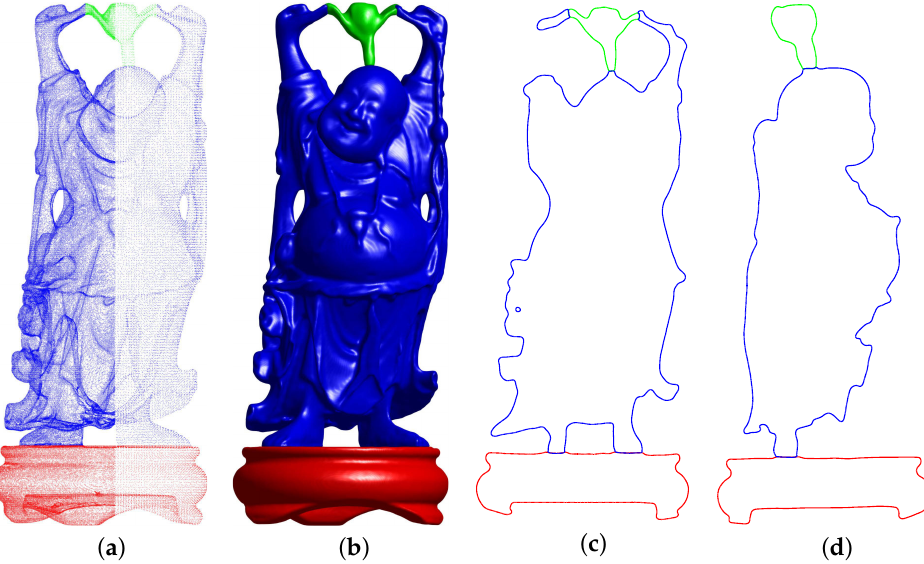
Figure 8. Multi-reconstruction with different densities of point data. ( a ) Initial input data. ( b ) Recon- structed surfaces. ( c , d ) The results in the different cross-view of ( b